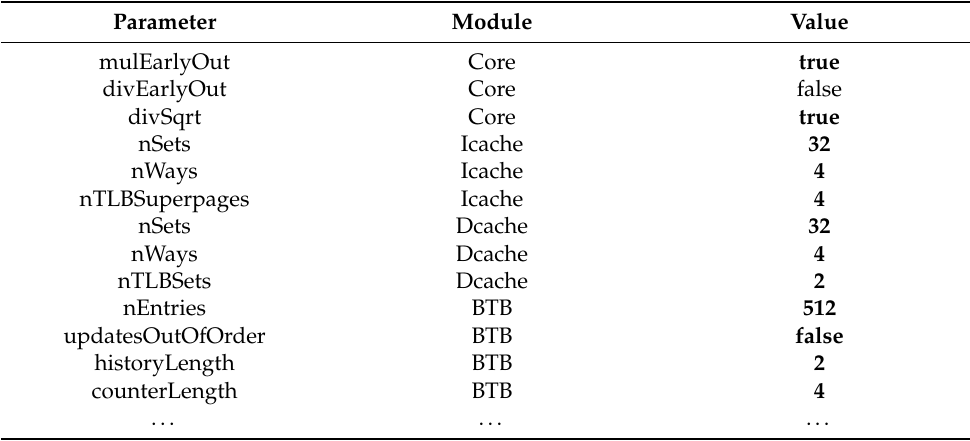
Table 3. An instance of the same portion of one changed